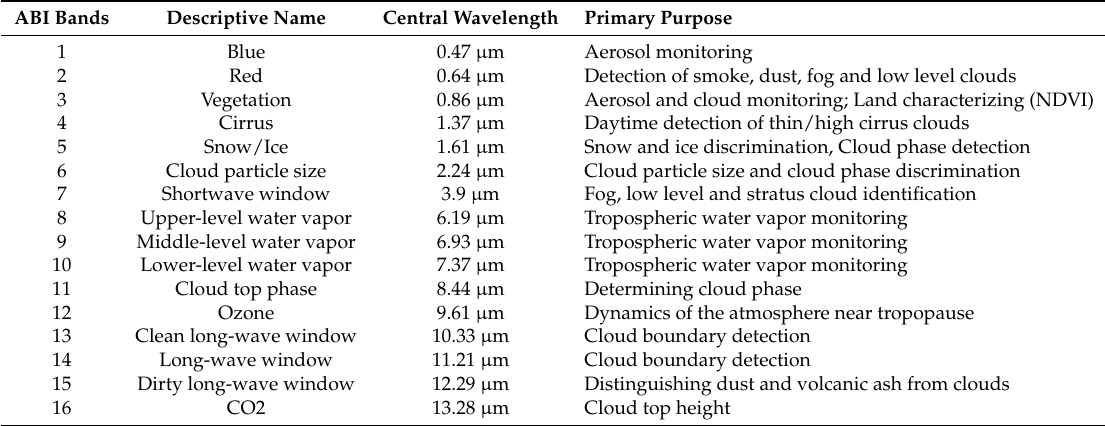
Table 2. Properties of ABI